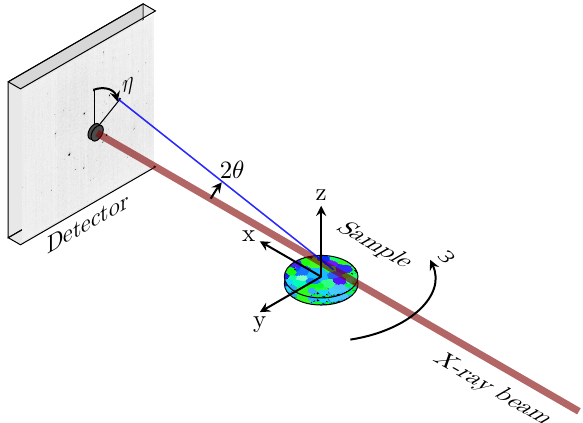
Figure 2. Illustration of the setup for the scanning 3DXRD experiment. The incident beam is focussed to a size smaller than the grain size of the polycrystalline sample, the size of the sample is 25µm. Diffraction patterns are collected on a 2D detector placed in the far-field regime, 163mm from the sample. The positions of the diffraction peaks are determined by the angles ( 2 θ , η ) . The direct beam is absorbed by a beam stop placed in front of the detector. The sample is scanned in the y and ω directions, i.e., the rotation axis is scanned across the beam and at each y position the sample is scanned y scans at several z -coordinates. in ω . Resolution in three dimensions is obtained by repeating the ω −